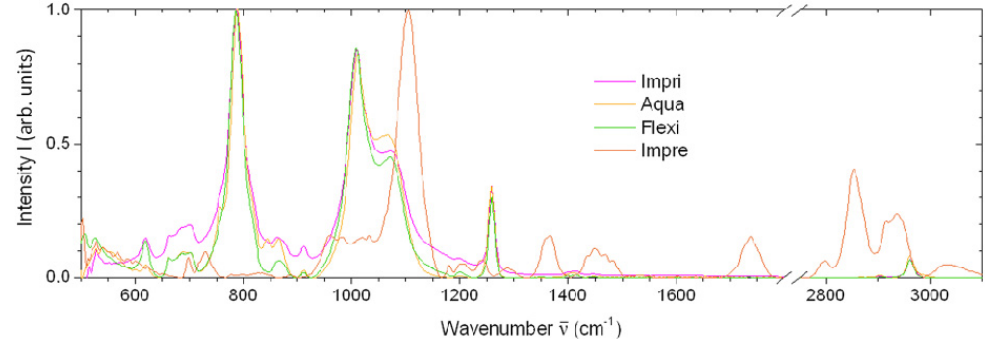
Figure 1. Fourier-transformed IR (FTIR) spectra of all the four materials investigated, at the shortest possible acquisition time since mixing (t ≈ 15